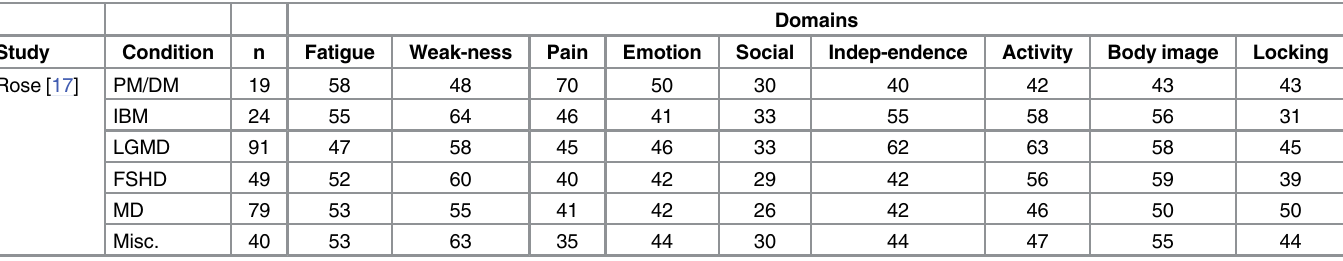
Table 5. Comparison of HRQoL between IIM and other neuromuscular diseases using the INQOL.